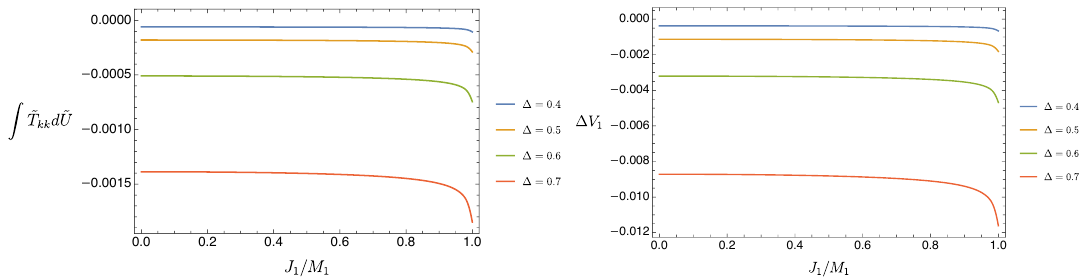
˜ ˜ T kk d U (left) and the = 1 , r = 100 , N + , 2